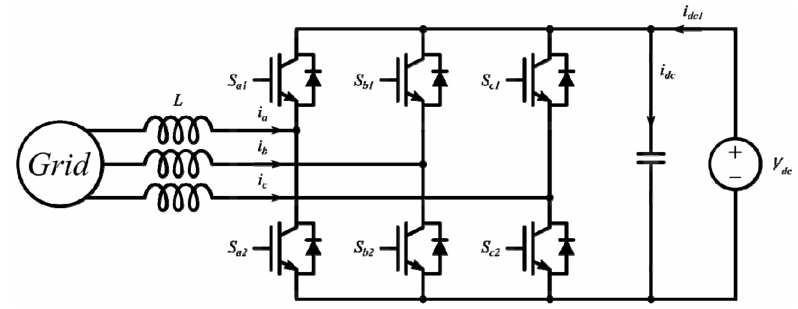
Figure 1. Grid-tied two-level voltage source inverter